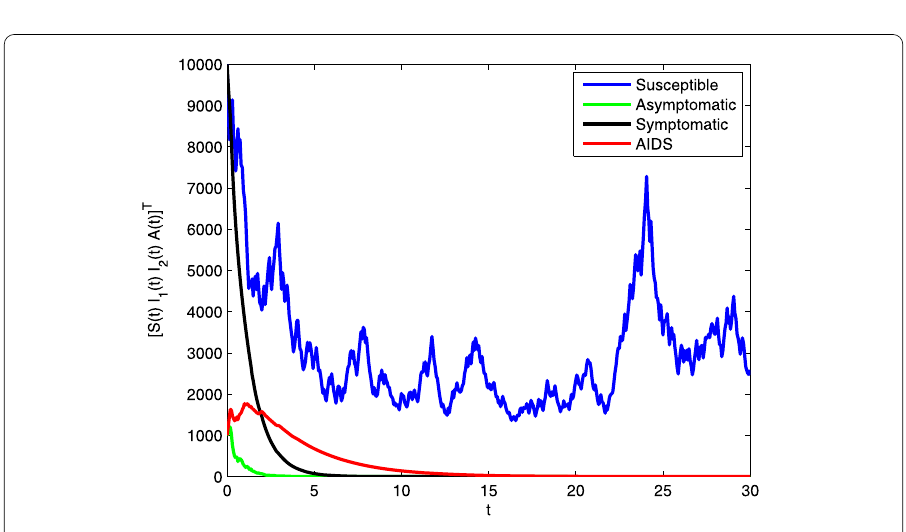
Figure 3 Simulations of system (1) with (cid:7) = 0.1, ϕ = ϕ 1 = ϕ 2 = ϕ 3 = 0.5, and τ = 0